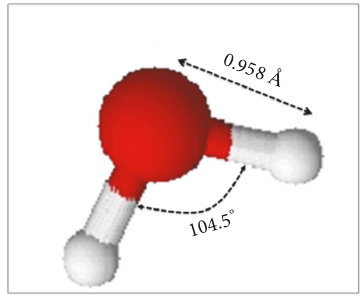
Figure 6: Geometry of water